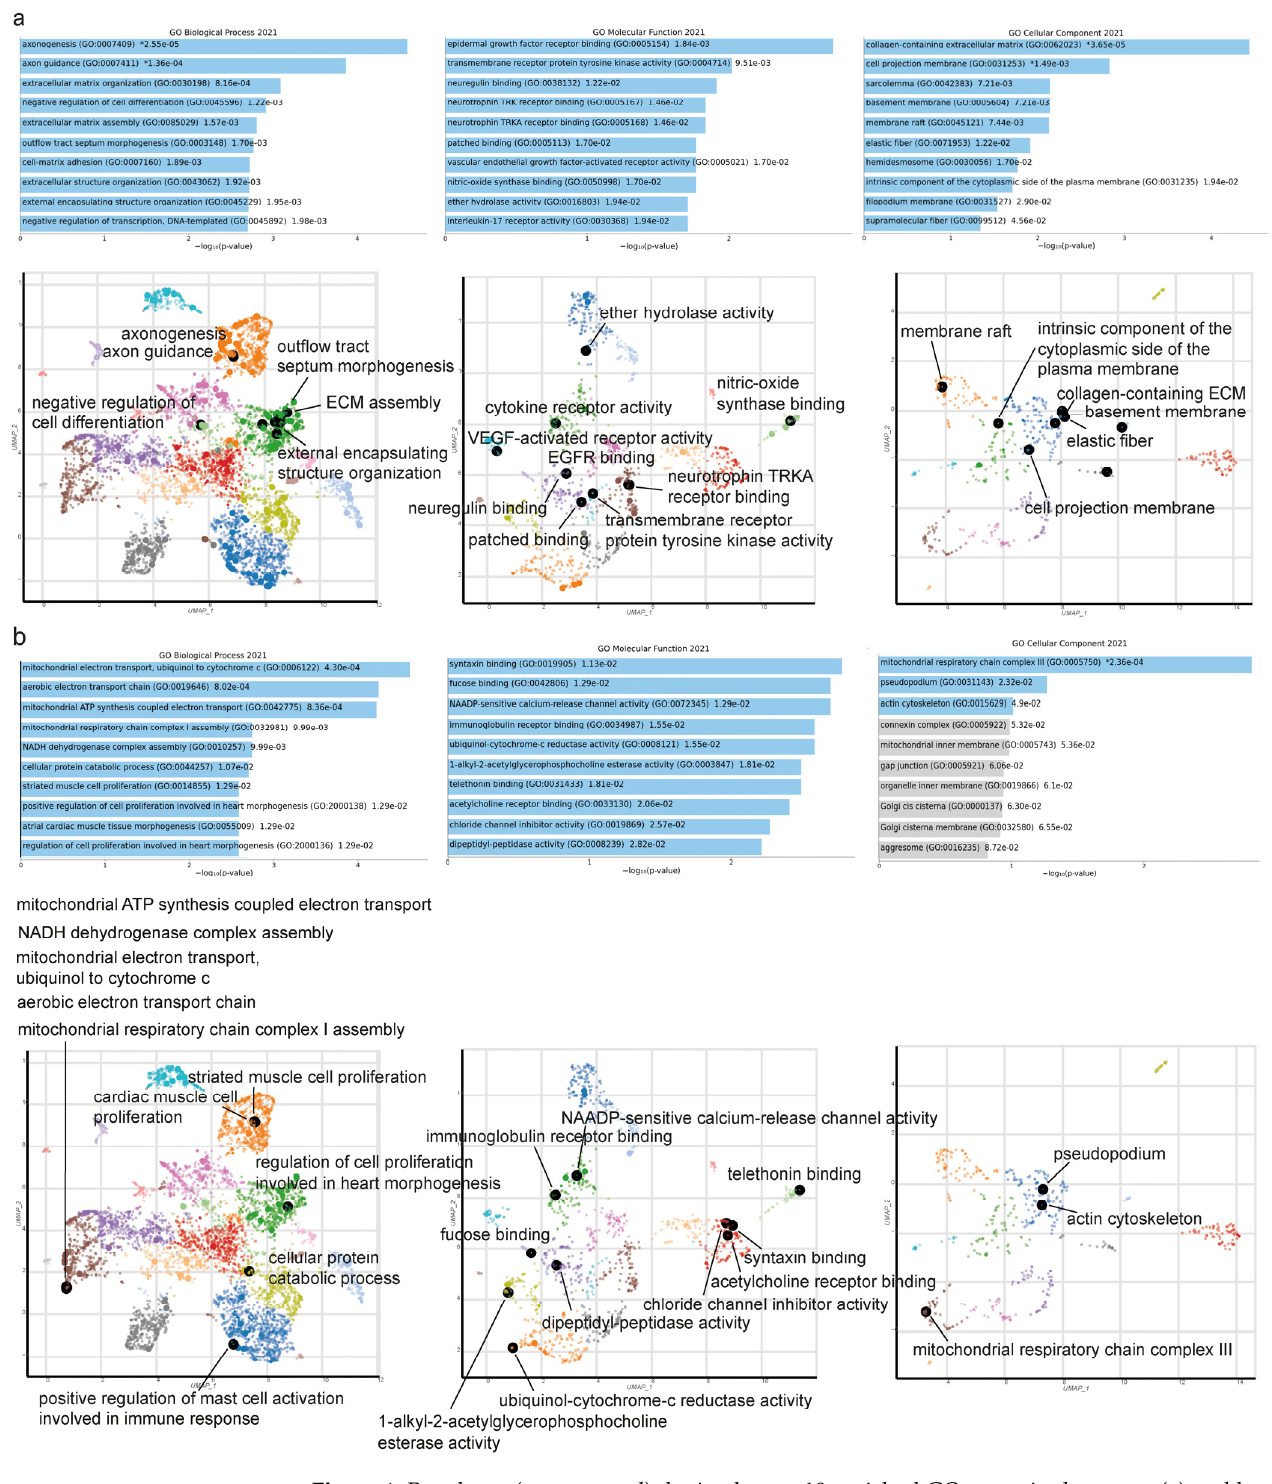
Figure 1. Bar charts (upper panel) depict the top 10 enriched GO terms in the upper ( a ) and lower ( b ) 50 deregulated genes in adult RUNX1/RUNX1T1 AML patients (GSE37642 dataset), along with their corresponding p -values (GO Biological Process; GO Molecular Function; GO Cellular Component). Statistically signi fi cant GO terms (adj. p < 0.05) are depicted with an asterisk (*). Sca tt erplots below show clusters of similar gene sets, the signi fi cantly enriched terms of which are denoted.